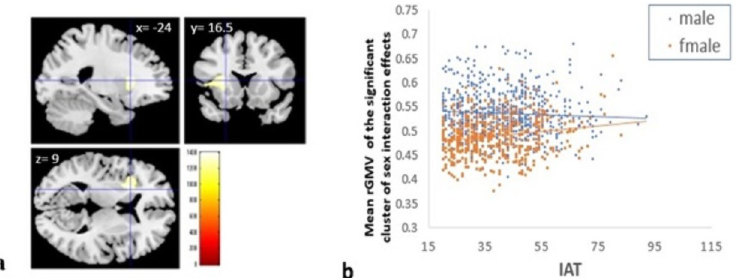
Fig 6. Interaction between sex and internet addiction tendency (IAT) scores. (a) Whole-brain analyses of rGMV show significant effects of interaction between sex and the score of Young’s IAT scale. Results were obtained using a threshold of threshold-free cluster enhancement (TFCE) of p < 0.05 based on 5,000 permutations. The significant effects of interaction were found in the area around the left anterior insula and left lentiform. This interaction is positively correlated in women (r = 0.171, p = 0.001), and not correlated in men (r = − 0.051, p = 0.189). (b) Scatterplot of the mean rGMV of the significant cluster of sex interaction effects in the left basal ganglia and left anterior insula.